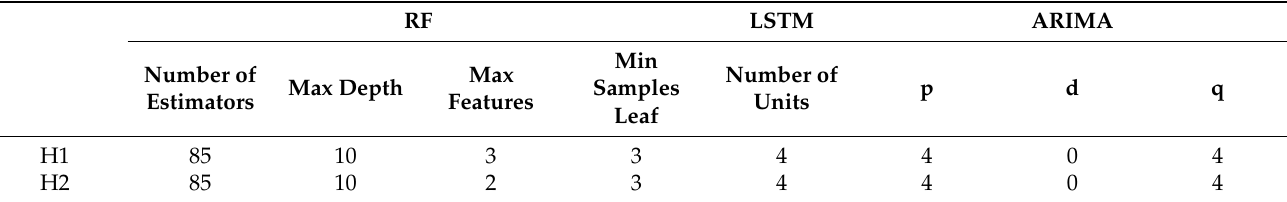
Table 6. Adjusted parameters of households H1 and